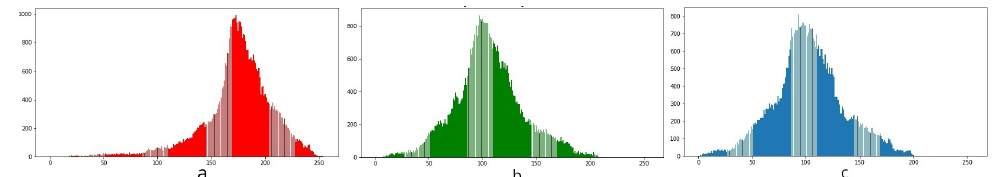
Figure 3. Color histograms of the training set for channels 0—red ( a ), 1—green ( b ), and 2—blue ( c ).